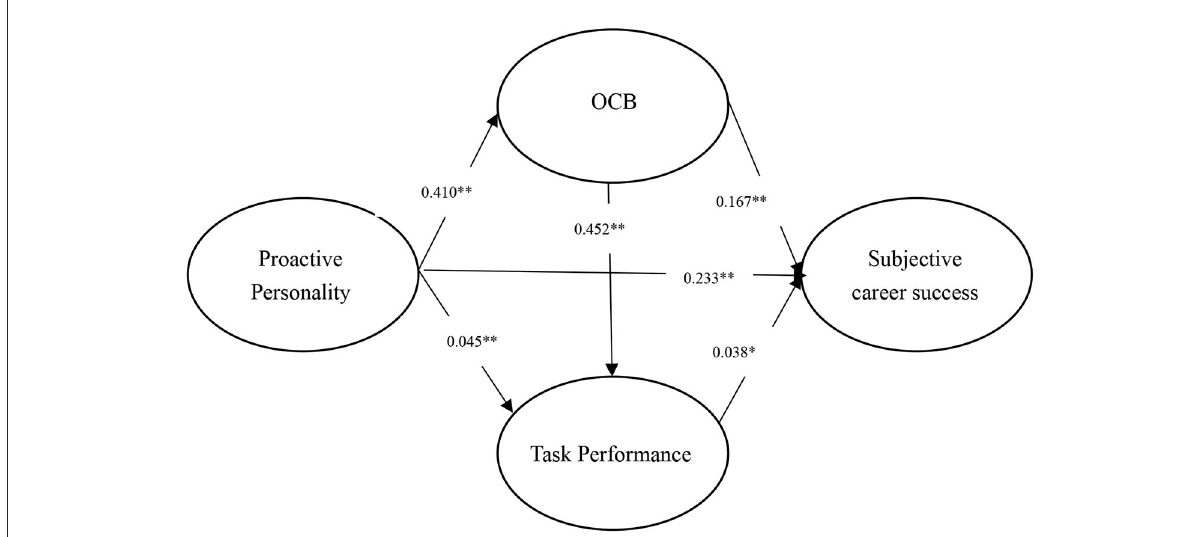
FIGURE3 Results of MASEM for proactive personality and subjective career success. ** p < 0.01; * p < 0.05.